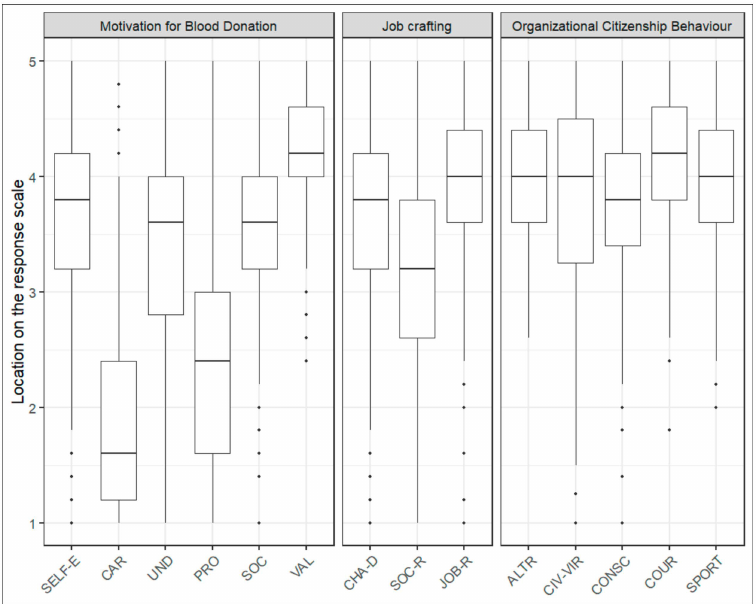
Figure 1. Location of the quantiles of the VFI Scale, JC Scale and OCB Scale on the continuum of the response